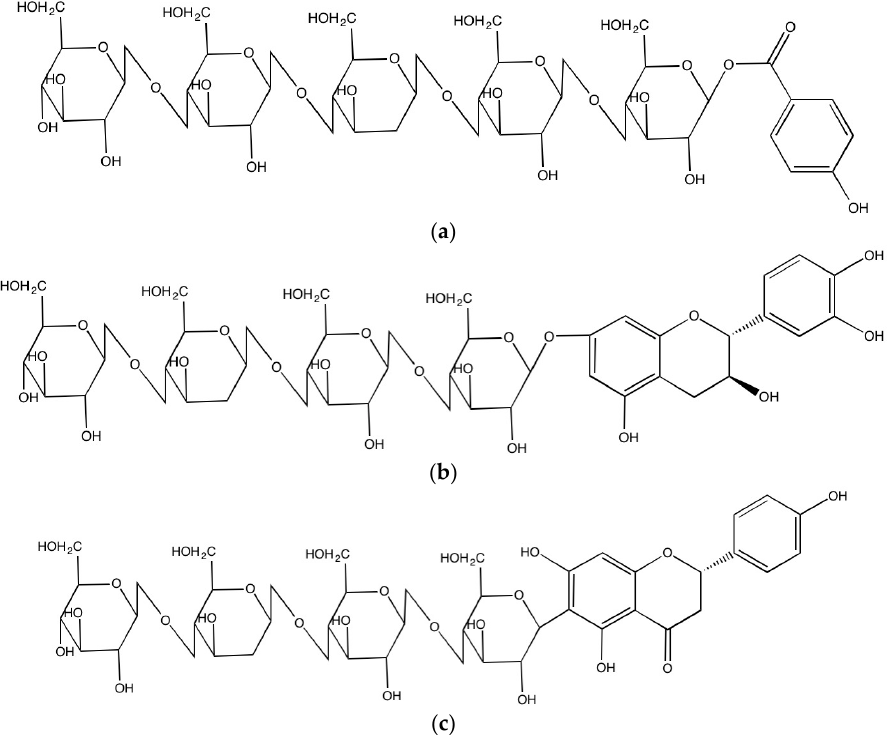
Figure 2. Representative covalent bonds found in insoluble-bound phenolics; ( a ) ester bond of 4-hydroxy benzoic acid ( b ) ether bond of catechin and ( c ) carbon-carbon bond of naringenin attached to cellulose molecule.